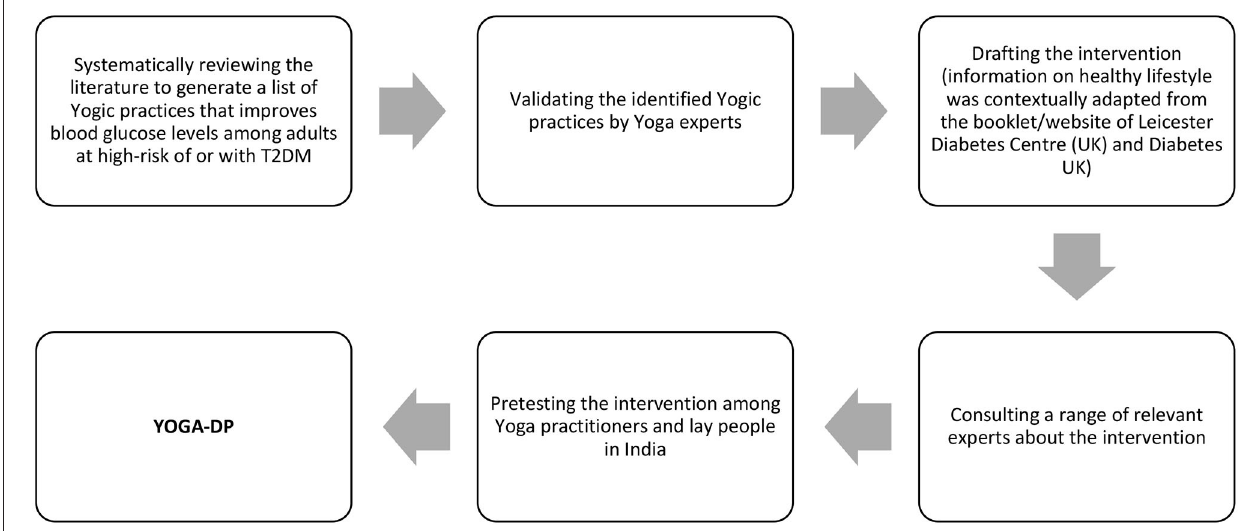
FIGURE 1 | Development process of